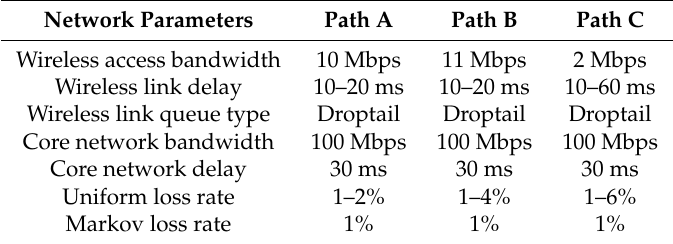
Table 3. Path parameter configuration used in the